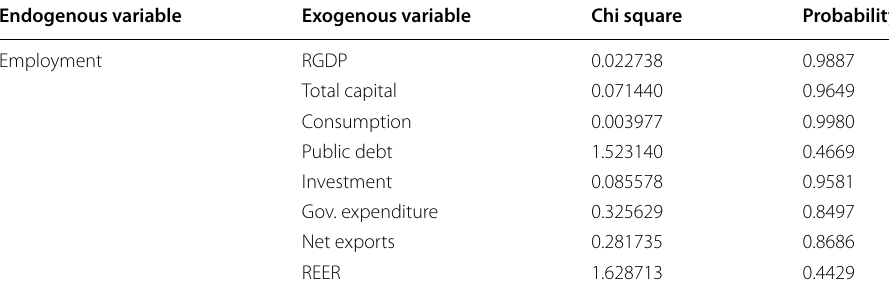
Table 10 Wald test results for Eq. (6). Source : Author’s calculations Endogenous